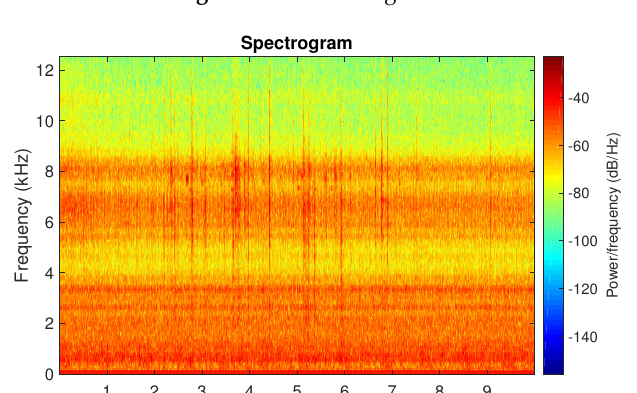
Figure 39. The real signal r .